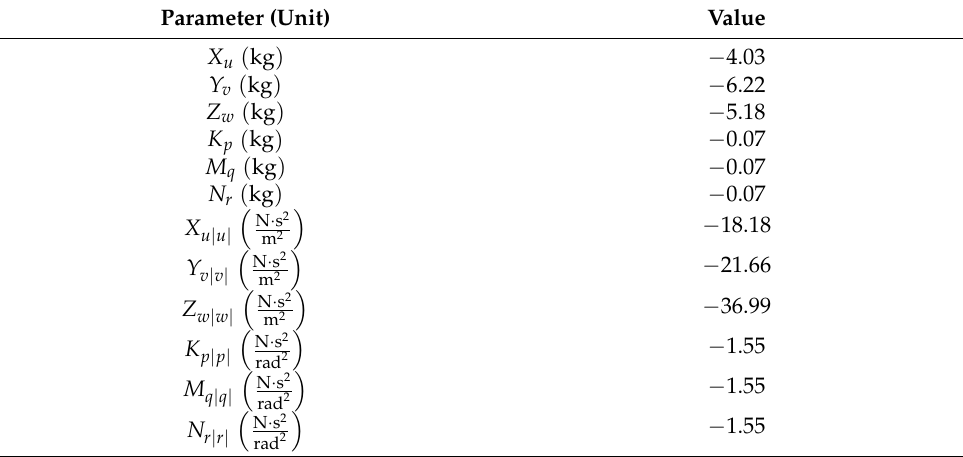
Table 5. Damping parameters for the BlueROV2